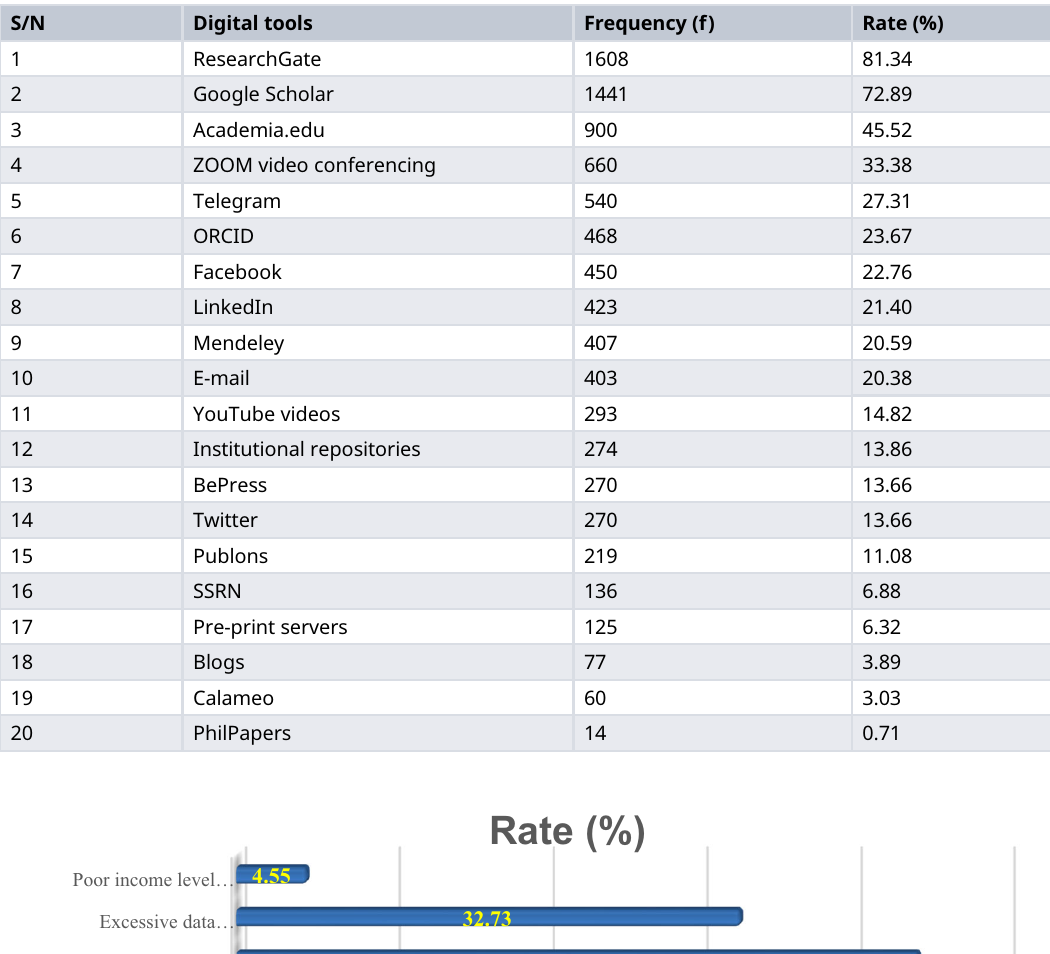
Table 2. Digital tools utilized by academic staff for research dissemination and the rate of utilization (N =